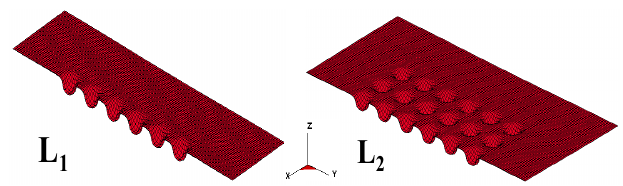
Figure 3. Measurement schematic diagram.